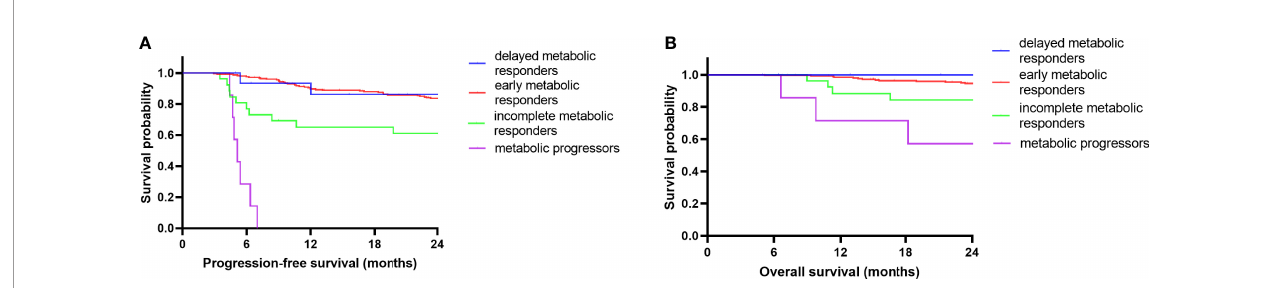
FIGURE 3 | Kaplan-Meier survival curves according to serial changes in PET-CT response. PFS (A) and OS (B) according to early metabolic responders (n=247), delayed metabolic responders (n=15), incomplete metabolic responders (n=26) and metabolic progressors (n=7) during frontline